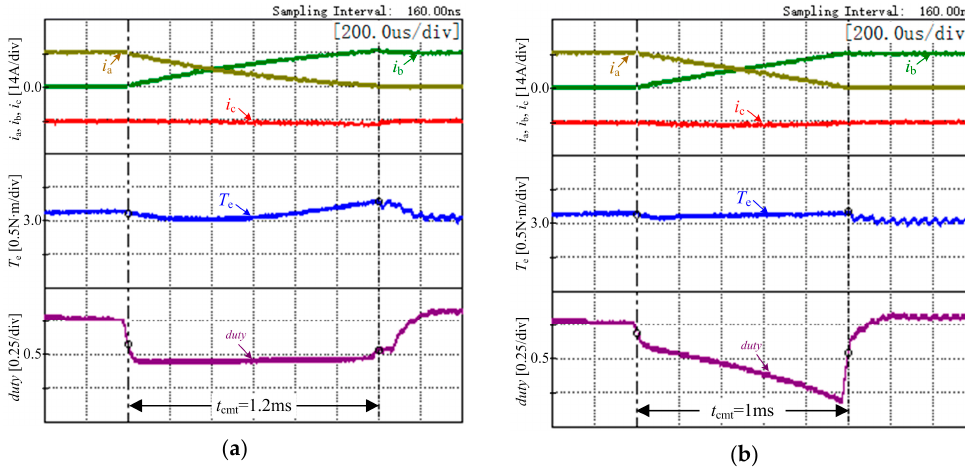
Figure 9. Enlarged waveforms of the commutation process under the rated load at 500 r/min. ( a ) the traditional strategy. ( b ) the proposed strategy.